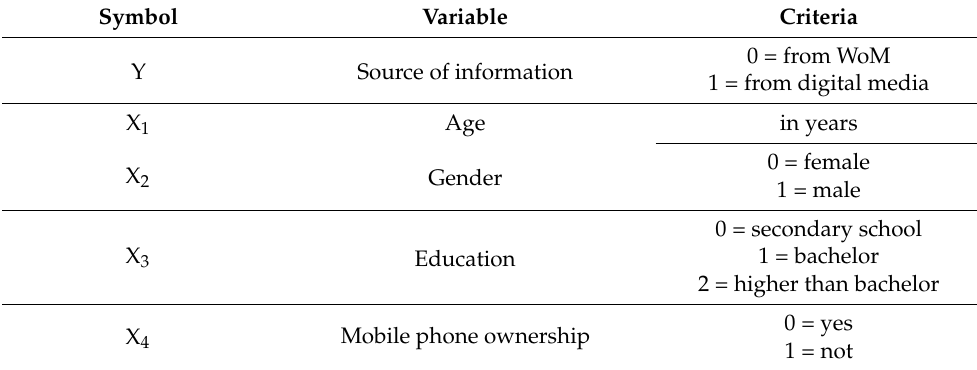
Table 1. The primary data types collected in this